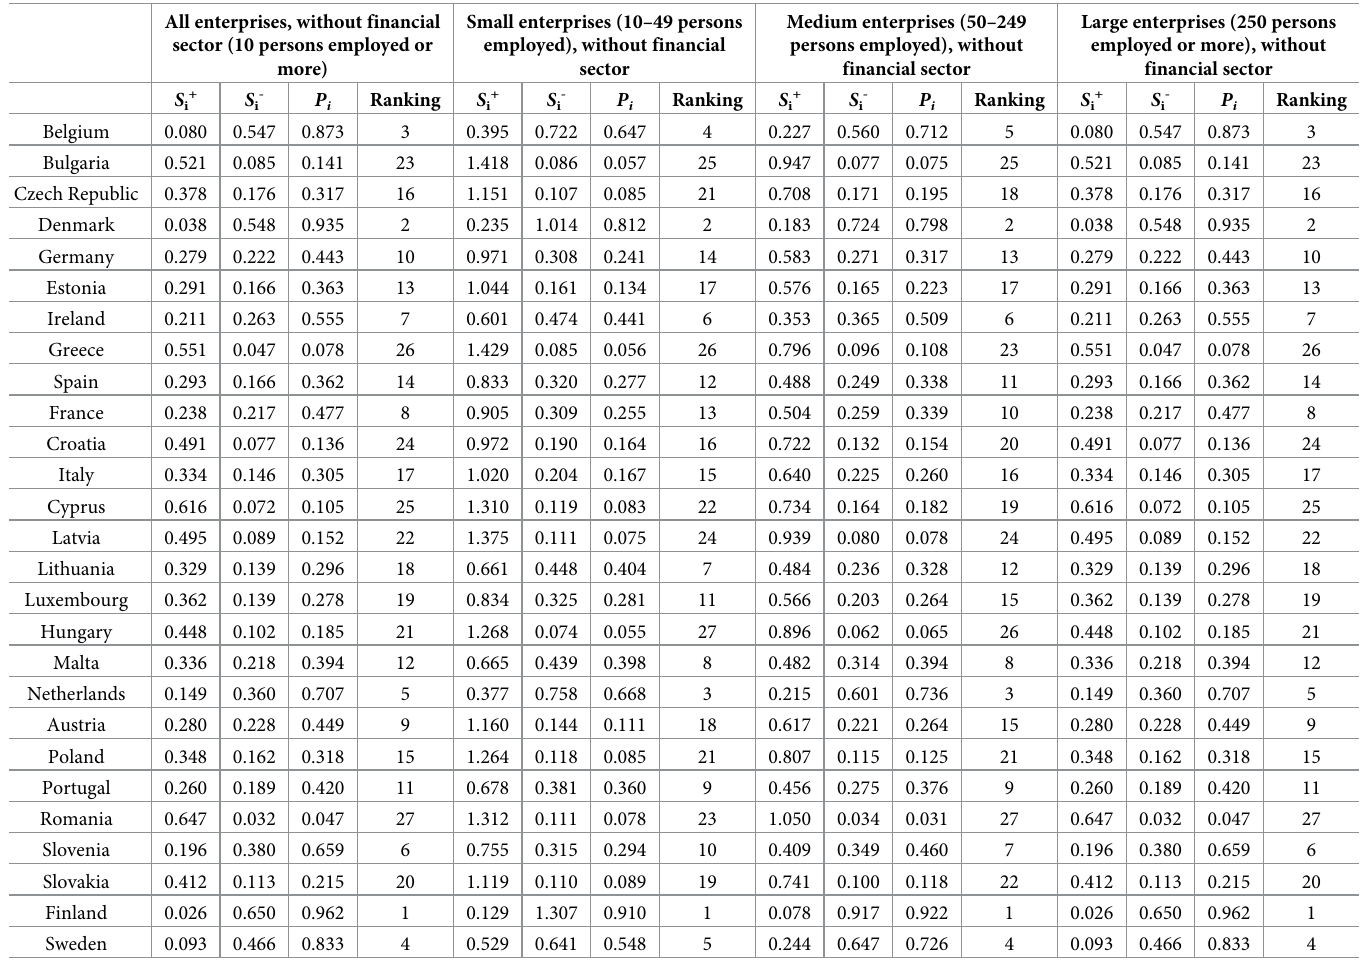
Table 6. Distance of the EU-27 countries from the pattern and anti-pattern together with the TOPSIS measure for the level of digitalization of individual groups of enterprise. All enterprises, without financial sector (10 persons employed